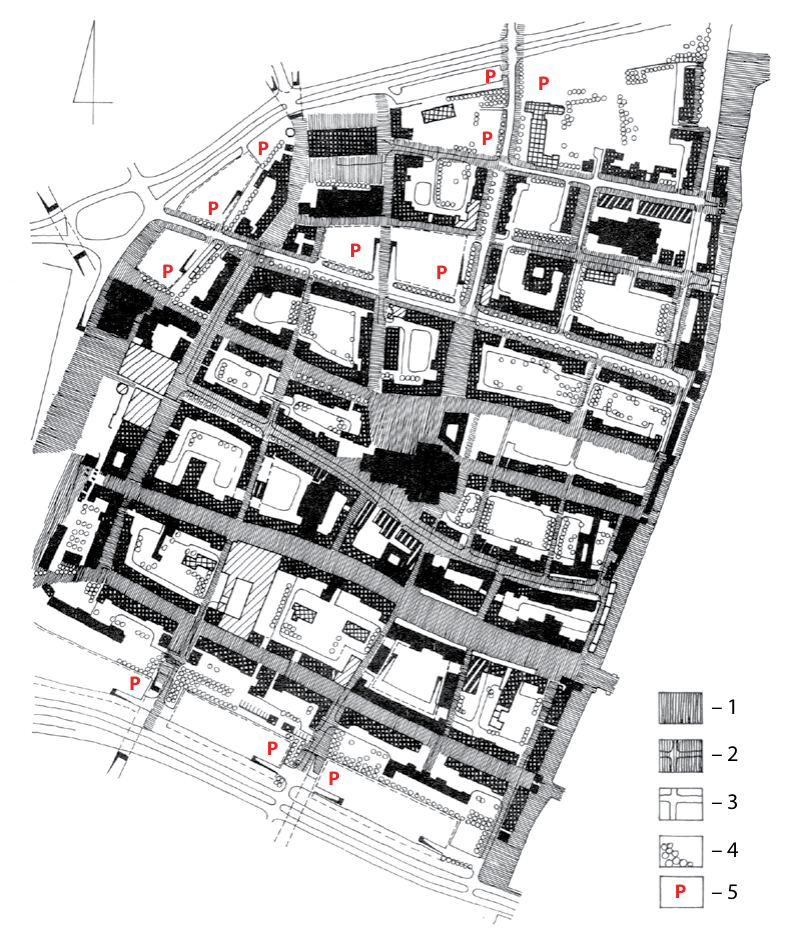
Fig. 3. Project of turning the centre of the old town of Gdansk into the compact pedestrian zone (architects V. Peškovski, n. Sienkievič, a. Valčyk, B. Zaveski): 1 – pedestrian street; 2 – pedestrian street with restricted automobile traffic; 3 – street